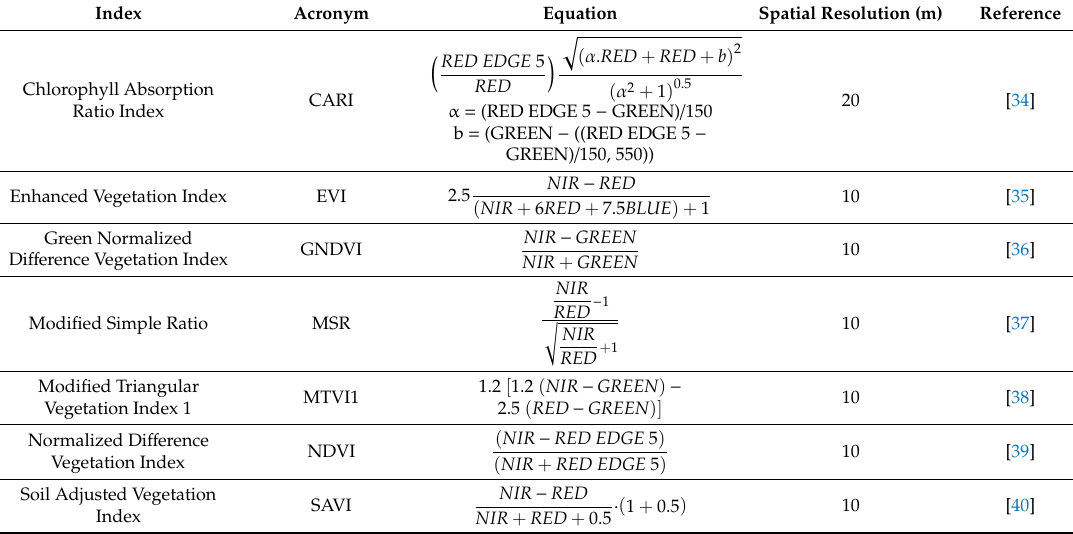
Table 4. List of the VIs used in this